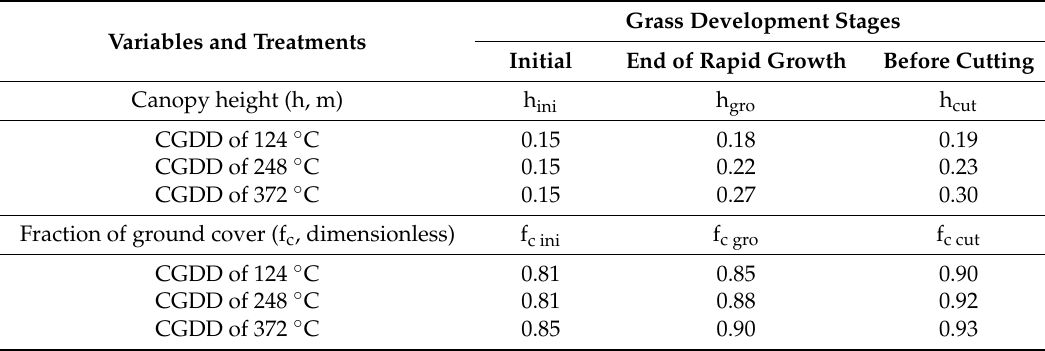
Table 4. Average of observed canopy height (h, m) and fraction of ground cover (fc, dimensionless) relative to treatments with various intervals between cuttings defined by observed